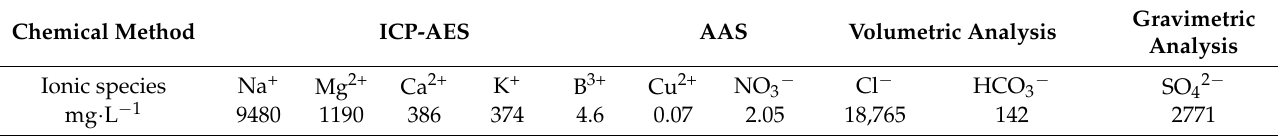
Table 2. Major constituents of seawater from San Jorge Bay, Chile (mg L − 1 ) [59].